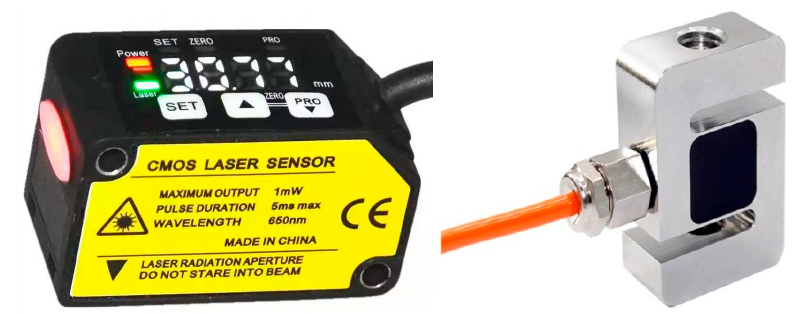
Figure 9. Digital display laser displacement sensor and load cell sensor of cable force.